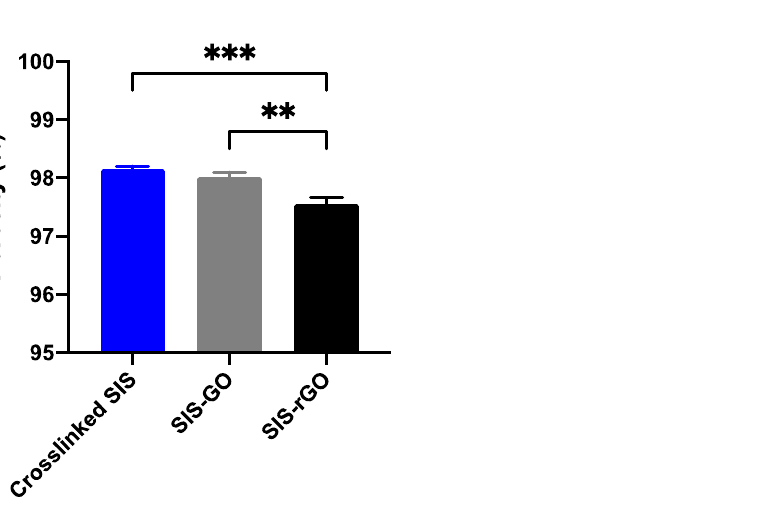
Figure 5. Porosity of the scaffolds calculated by the liquid displacement method. Results with a p -value ≤ 0.05 (*) were considered statistically different. Symbol * corresponds to statistically significant difference with a p -value in the range of 0.01 ≤ p -value ≤ 0.05, ** to statistically significant difference with a p -value in the range of 0.001 ≤ p -value < 0.01, *** to p -value in the range of 0.0001 ≤ p -value ≤ 0.00 and **** to p -value < 0.0001.